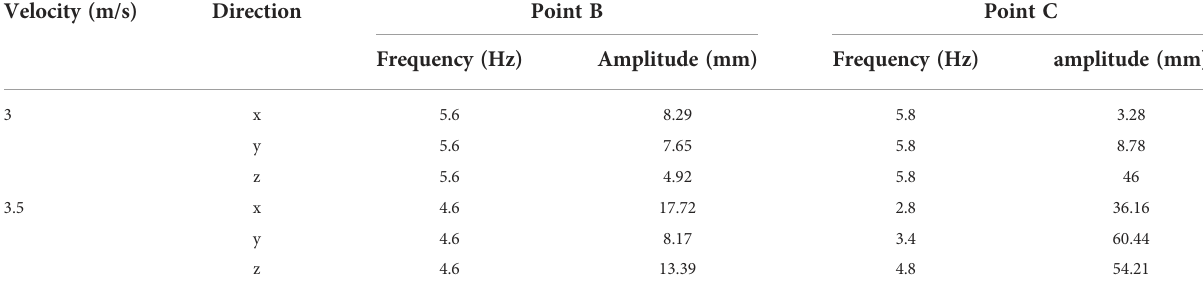
TABLE 2 Vibration frequency and amplitude of points B and C at v =3.0m/s and v =3.5m/s. Velocity (m/s)